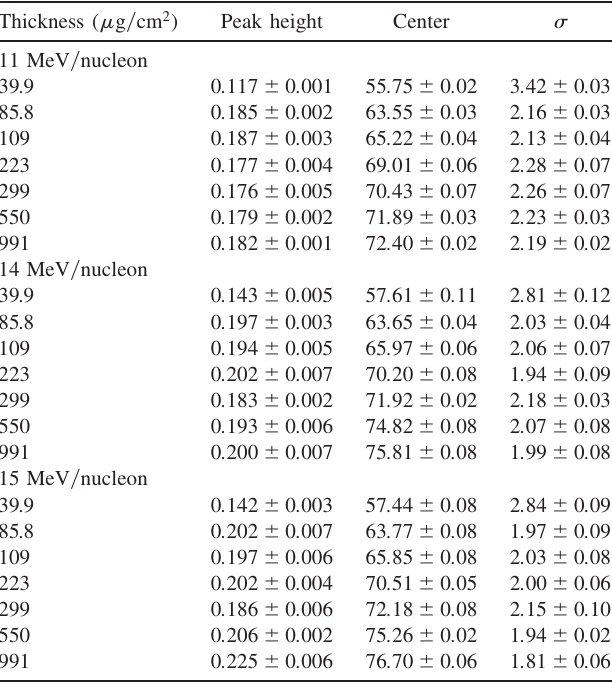
TABLE III. Fitting parameters of 238 U charge-state distribu- tions using the C-foil charge stripper. The listed errors are attributed to the fitting